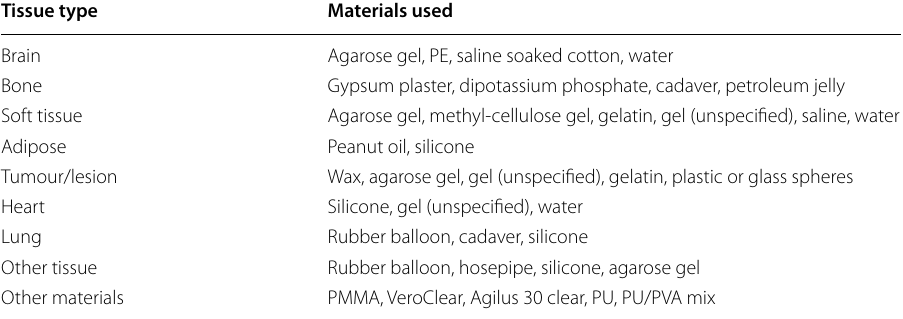
Table 2 Materials used in anthropomorphic phantoms categorised by the tissues they have been used to